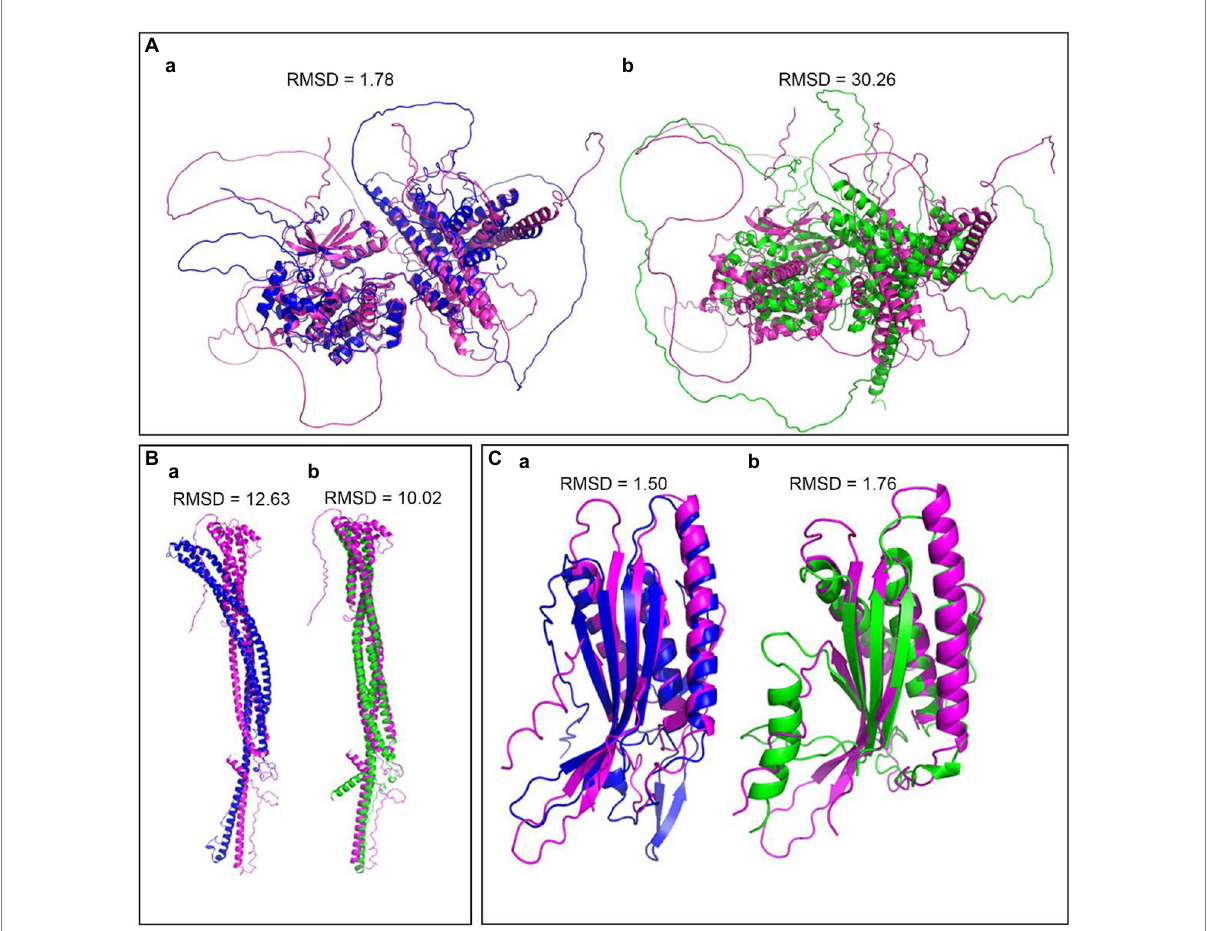
FIGURE 3 Structural differentiation of the Atg1 complex between rice blast fungus, yeast and mammals. (A) The predicted structure of Atg1 by Alphafold2, Pink-MoAtg1, Bule-ScAtg1, green-SpAtg1. (B) The predicted structures of Atg17, Pink-MoAtg17, Bule-ScAtg17, green-SpAtg17. (C) The predicted structures of Atg101, Pink-MoAtg101, Bule-HoAtg101, and green-SpAtg101. RMSD (Root Mean Square Deviation) value is used to measure the similarity of two structures. A smaller RMSD value indicates a higher degree of